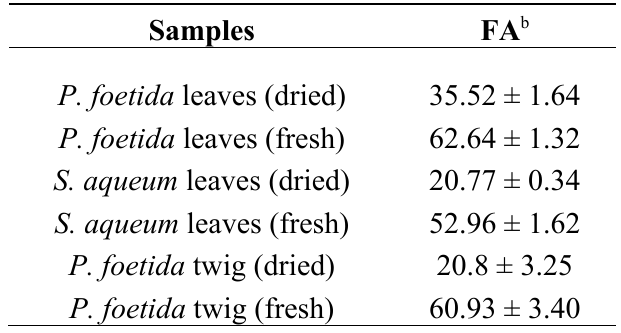
Table 1 . Total phenolic contents of P. foetida and S. aqueum.